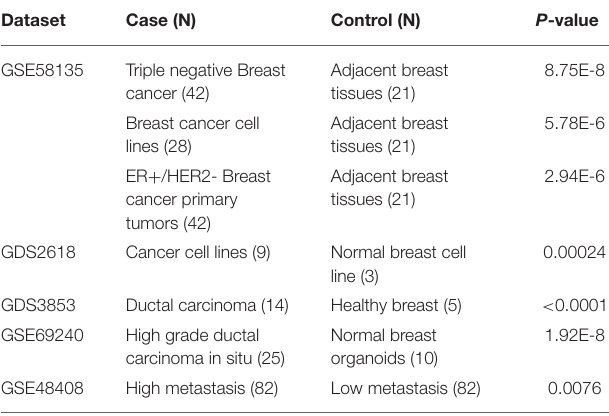
TABLE 1 | The Up-regulation of HOTAIR in breast cancer samples (case) compared to normal samples (controls) in different GEO datasets.